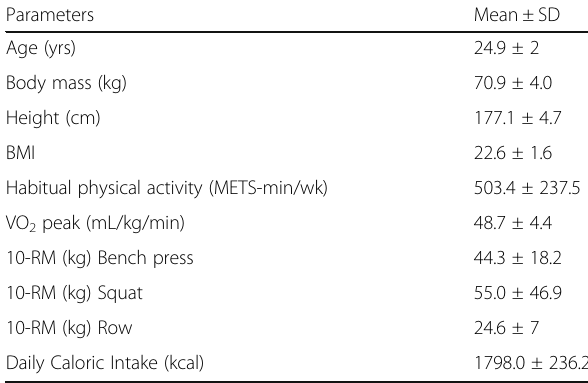
Table 1 Descriptive data of